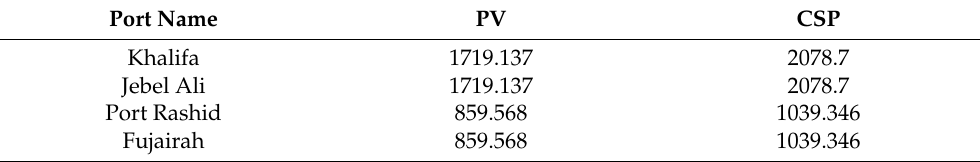
Figure 6. First pathway GIS analysis results for closest ports and shortest routes.